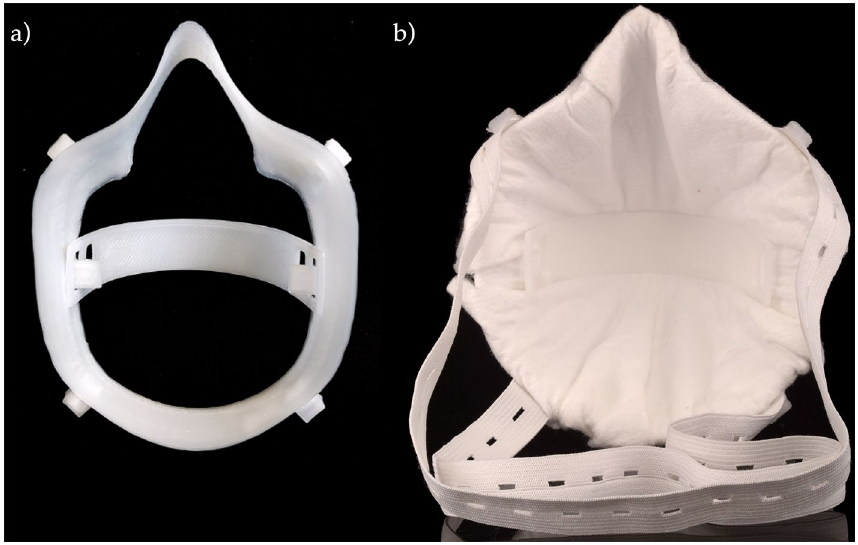
Figure 8. (a) Test fitting of the 3D-printed statistically shaped mask frame and tensioner; (b) fully assembled statistically shaped mask incorporating a sample filter